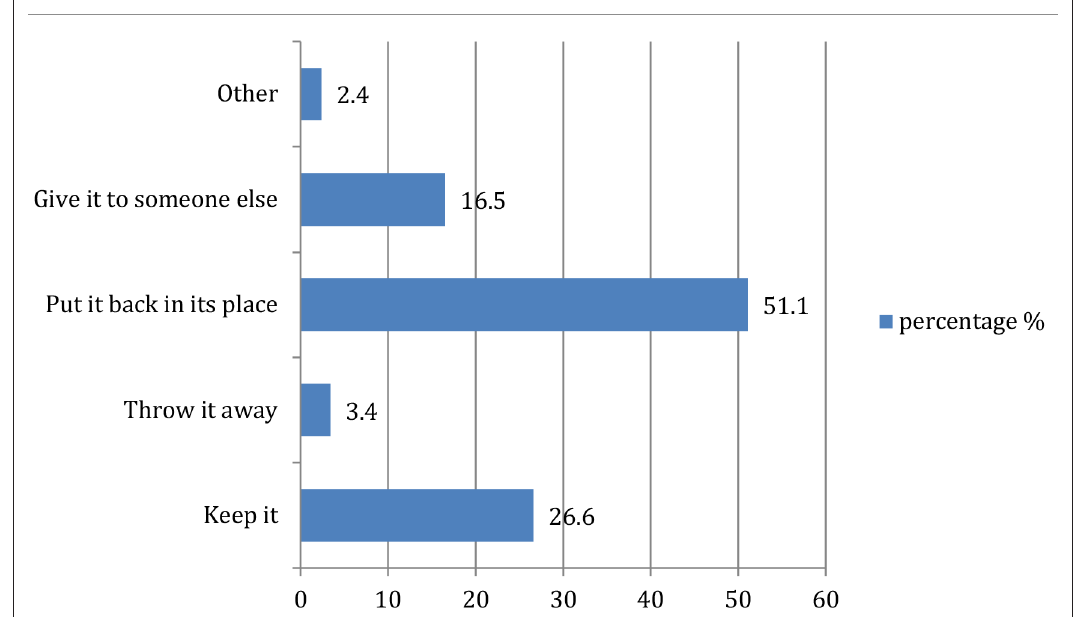
Figure 2 What participants usually do after reading the printed